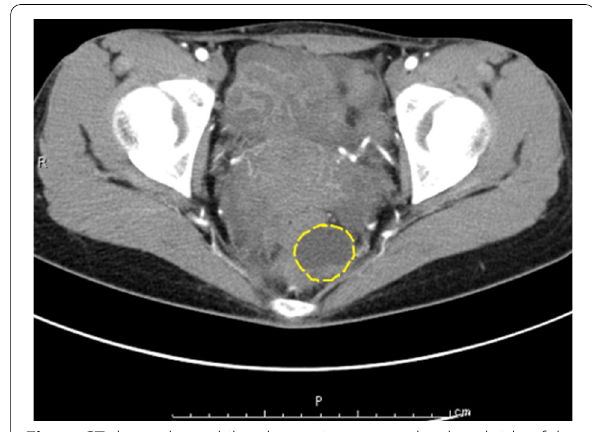
Fig. 1 CT showed a multilocular cystic mass on the dorsal side of the rectum in front of the sacrum (dotted line)